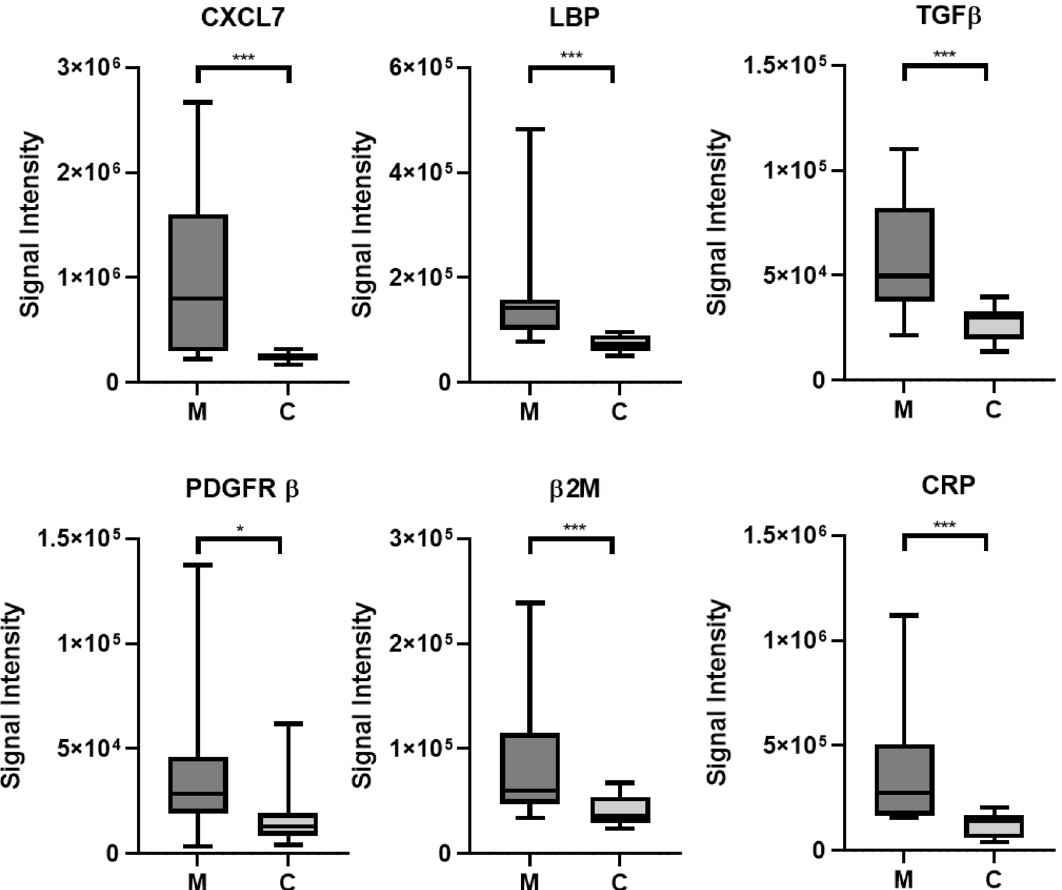
Figure 4. SWATH-MS analysis of plasma levels of key significantly upregulated immune proteins in mastocytosis patients. Plasma protein measurements were compared between systemic mastocytosis patients (n = 12) and healthy controls (n = 8). Significance was determined using a modified Welch’s T-Test using the SWATH analysis software MarkerView, p < 0.05 was considered statistically significant (*p < 0.05, **< 0.01, ***< 0.001). Plots show the minimum and maximum